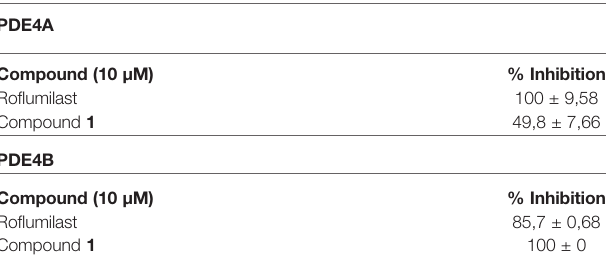
TABLE 2 | Results of PDE4 in vitro inhibition.